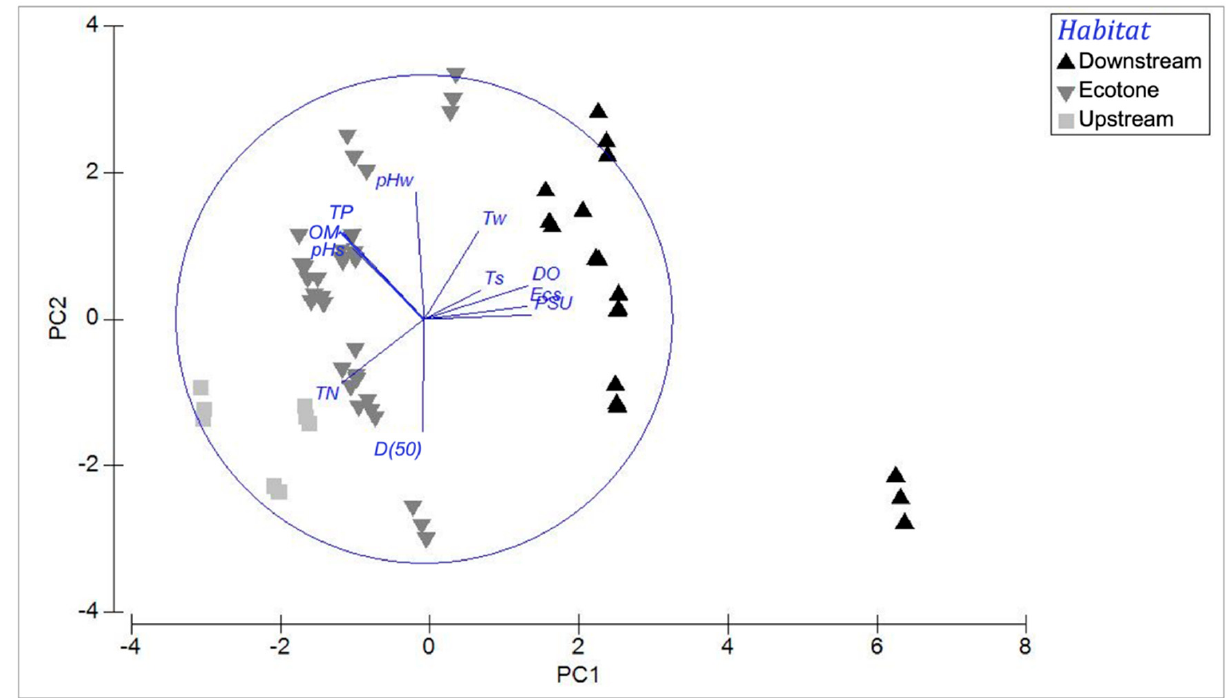
Figure 2. Principal component analysis based on environmental conditions in the Van Uc River (PC1 = 44.1% and PC2 = 24.7%). The circle displays correlation coefficients of the variables with the first two principal axes; the closer the projection vector is to the circle border, the higher the correlation